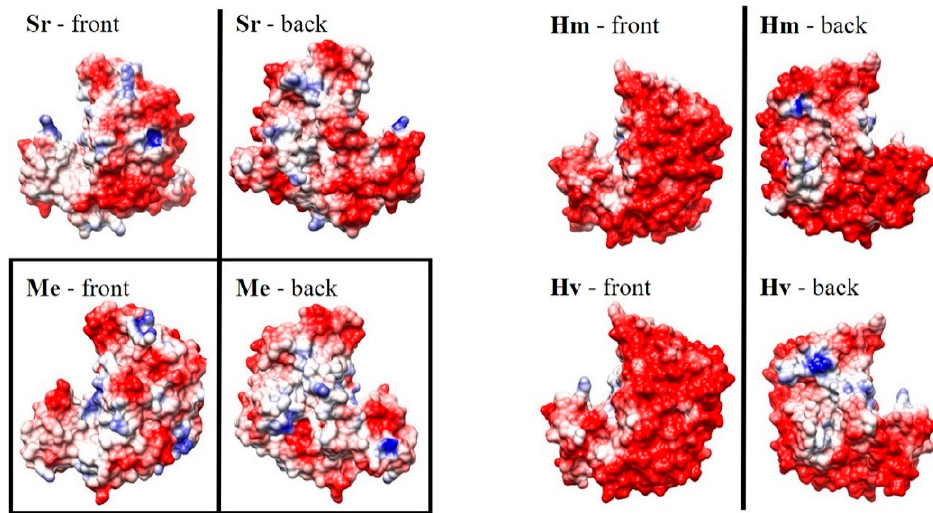
Figure 6. Coulombic surface maps for both sides of the Salinibacter ruber (Sr), Haloarcula morimortui (Hm), Haloferax volcanii (Hv) and Methylobacterium extorquens (Me) malate dehydrogenases. The halophilic structures display negative surface areas (in red), a common feature of halophilic proteins. Reprinted with permission from [101].